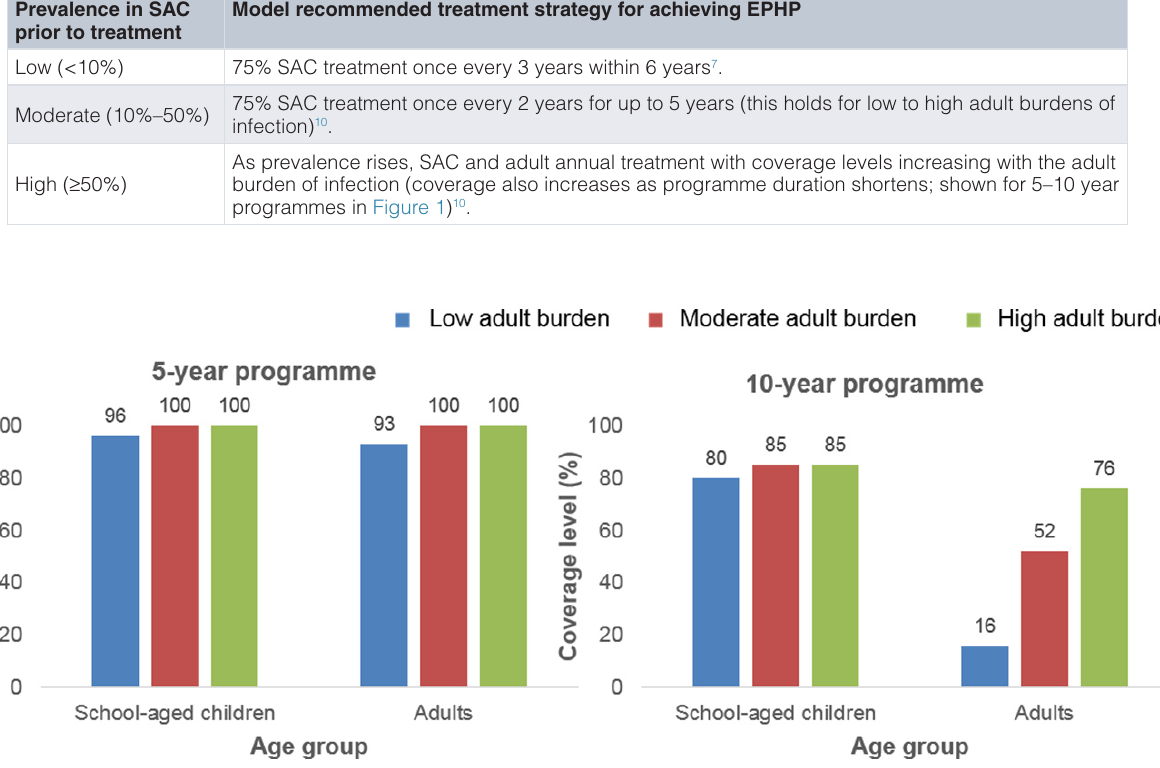
Table 2. Model recommended treatment strategies for achieving elimination as a public health problem (EPHP) in low to high prevalence settings. SAC refers to school-aged children aged 5–14 years old. Prevalence in SAC prior to treatment